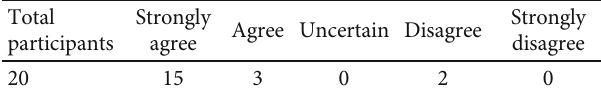
Table 6: Experiment result